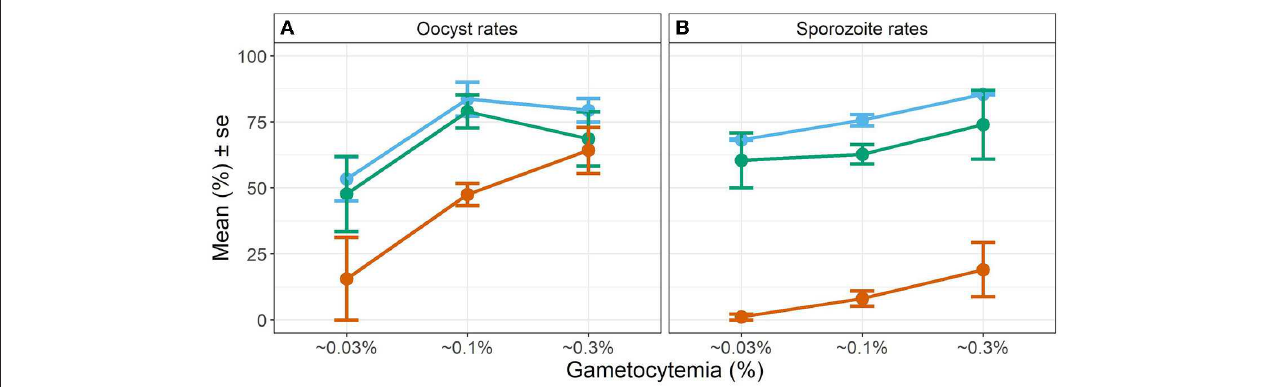
FIGURE 3 | Effect of gametocyte density and temperature on oocyst rates in midguts (A) and sporozoite rates in the salivary glands (B) . Values represents means ± standard error (se) from three biological replicates. The color scheme is continued from Figure 2 with blue representing 20 DTR 9 ◦ C, green representing 24 DTR 9 ◦ C and red/vermillion indicating 28 DTR 9 ◦ C.